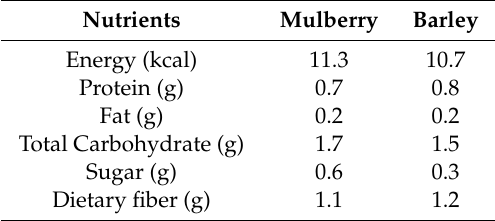
Table 2. Nutrition facts for powdered mulberry and barley leaves (for a 3 g